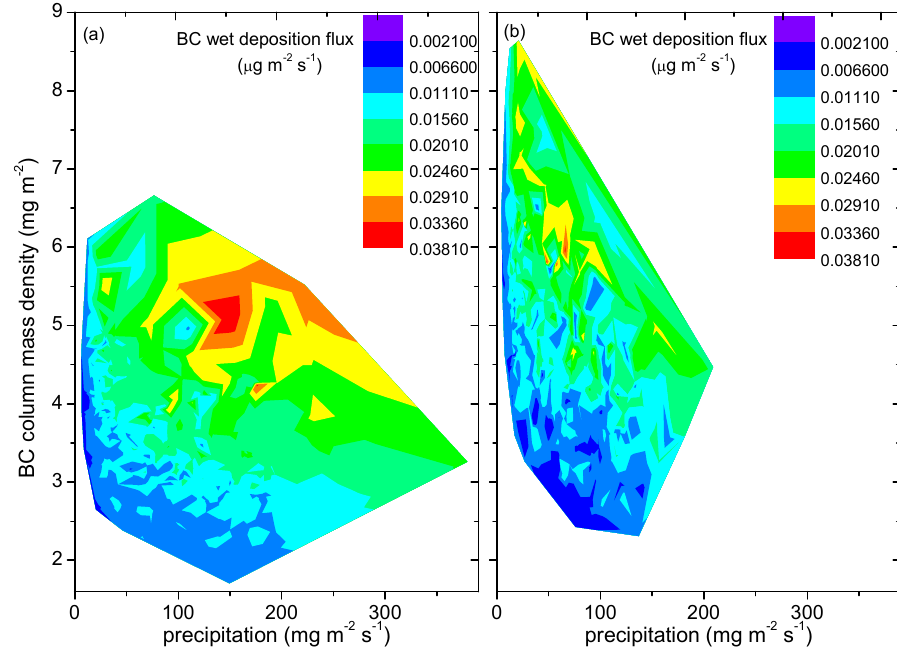
Figure 10. The wet deposition-concentration-precipitation (WETD-C-P) relationships. The relation- ships of monthly BC wet deposition flux with precipitation and BC column mass density in region A (28° N–31° N, 103° E–104° E) ( a ) and region B (28° N–29° N, 104° E–106° E) ( b ).